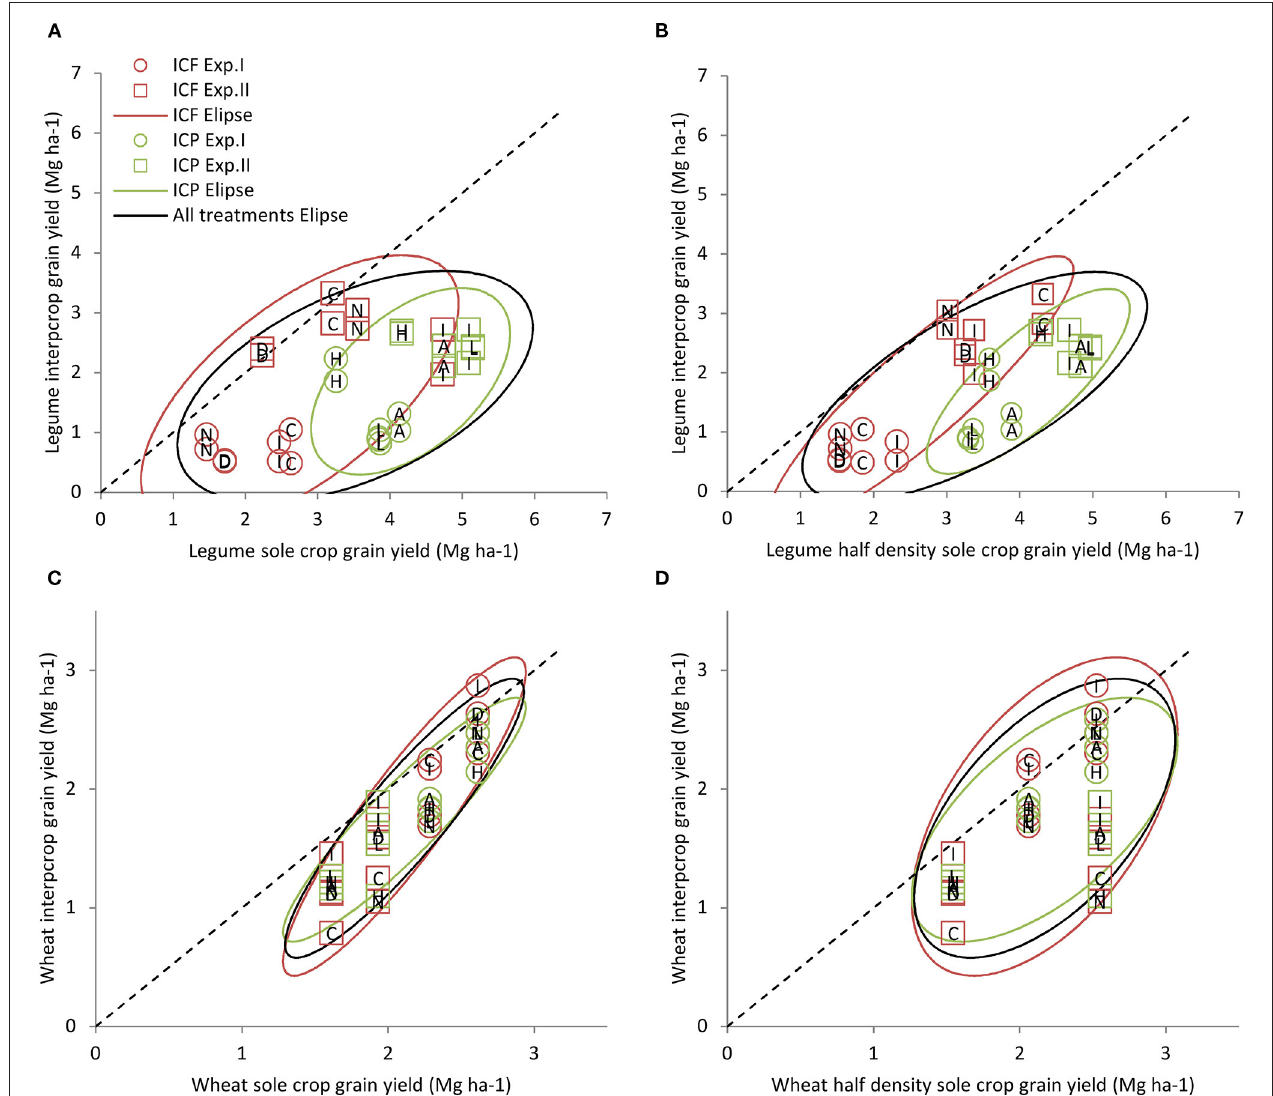
FIGURE 3 | Comparison of yields achieved in IC vs. sole crops for the legumes and wheat. The yield achieved in intercrop by legumes (A, B) or wheat (C, D) as a function of that in SCs (A, C) or SC ½ (B, D) . Symbols correspond to durum wheat–faba bean intercrop (ICF) (red), durum wheat–pea intercrop (ICP) (green), Exp.I (circles), Exp.II (squares), L1823 wheat cultivar (open), and Sculptur wheat cultivar (closed). The ellipses represent the prediction interval at p = 0.90 in red for ICF, in green for ICP, and in black for both the ICF and ICP. Each point corresponds to the mean of three replicates’